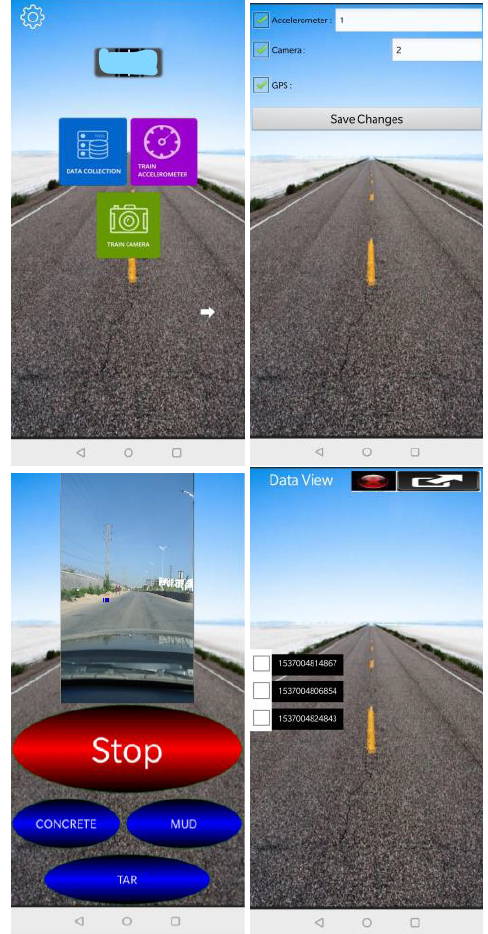
Figure 2. Mobile Application